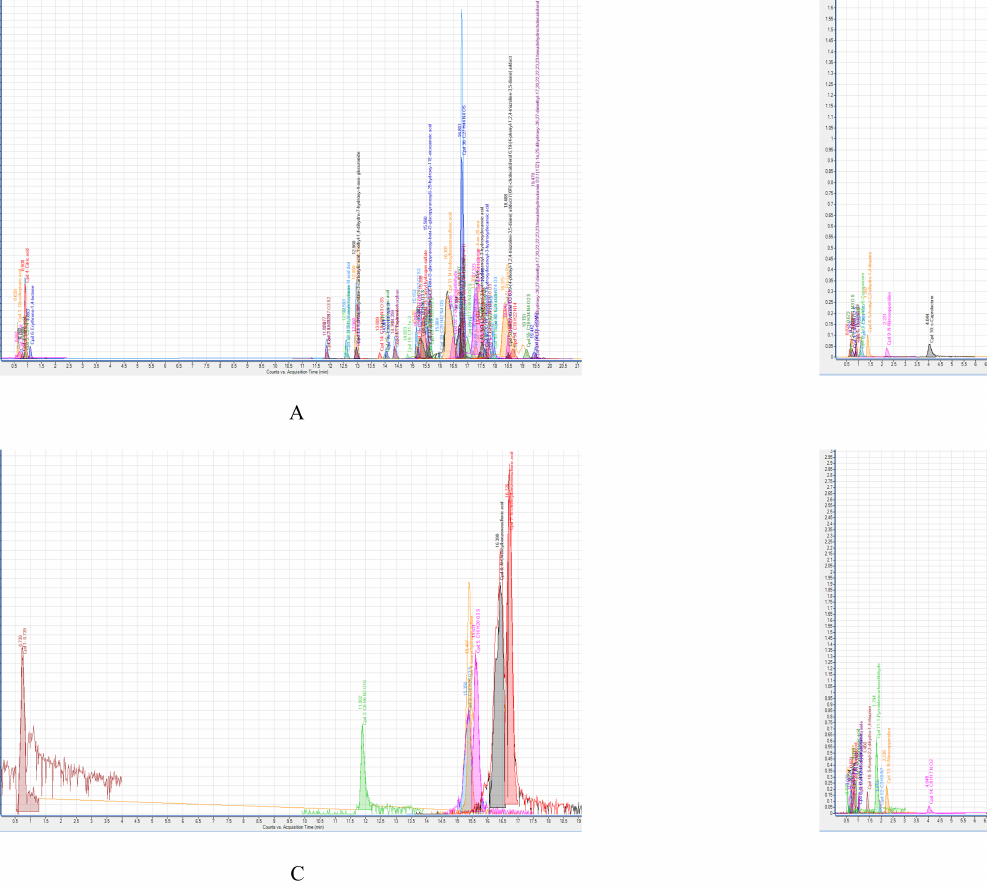
Figure 4. The LC–MS spectra of the e ff ective conditioned media prepared from bacteria isolated from the gastrointestinal tract of scorpion, H. spinifer : HSG12 ( P. aeruginosa ) and HSG16 ( B. subtilis ) when subjected to Agilent Technologies 6520 Accurate-Mass Q-TOF mass spectrometer with dual ESI source LC–MS analysis. Briefly the conditioned media was subjected to chloroform extraction and the extract was dried under pressure and dissolved in HPLC-grade methanol for LC–MS analysis. ( A ) The spectrum of molecules detected for negative ion polarity from HSG12. ( B ) The spectrum of molecules detected for positive ion polarity from HSG12. ( C ) The spectrum of molecules detected for negative ion polarity from HSG16. ( D ) The spectrum of molecules detected for positive ion polarity from